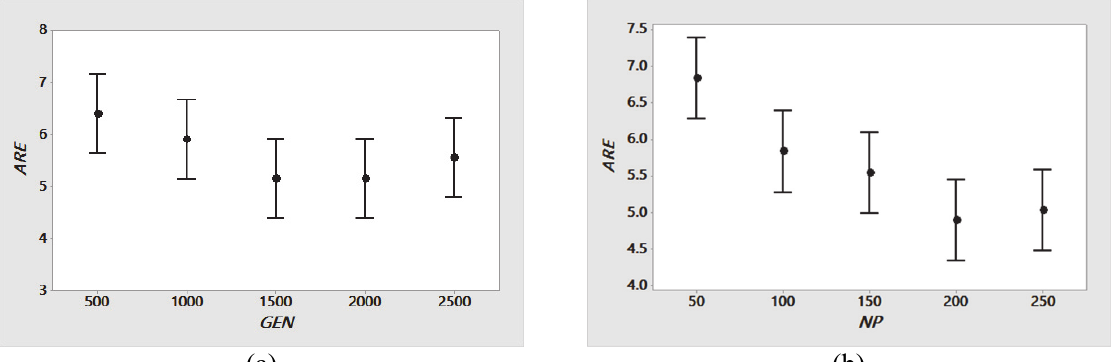
Fig. 4. ARE mean plots of parameters for 100×20 problem size (a) GEN factor (b) NP factor (95%